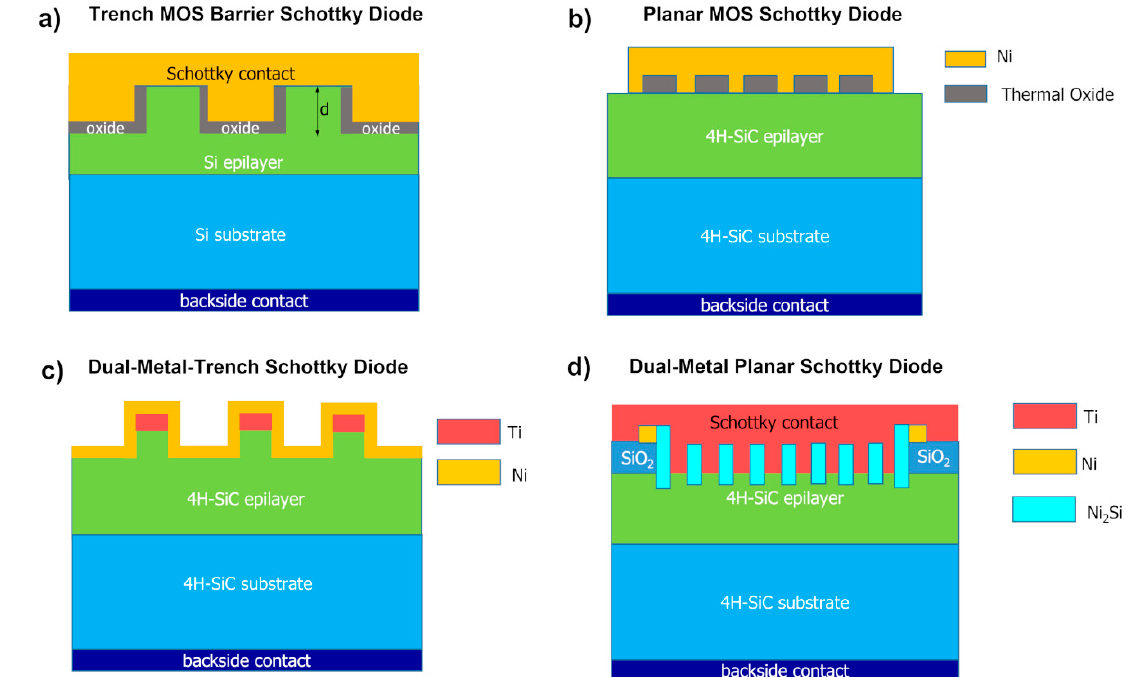
Figure 6. Different Schottky diode layouts proposed to achieve an optimal trade-off between the forward and reverse characteristics. ( a ) Trench MOS barrier Schottky (TMBS) diode. ( b ) Planar MOS Schottky diode (MOSSD). ( c ) Dual-metal-trench (DMT) Schottky diode with Ti and Ni Schottky contact. ( d ) Dual-metal-planar (DMP) Ti-Ni 2 Si/4H-SiC Schottky diode.